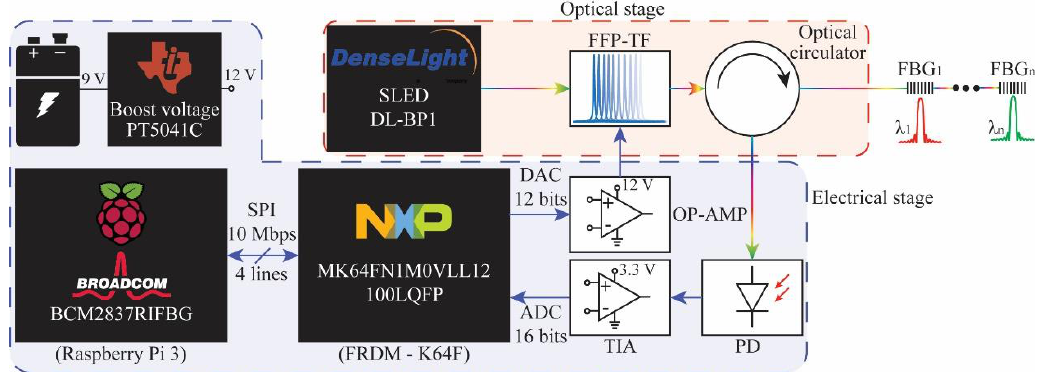
Figure 1. Schematic of the proposed interrogator, where the electrical and optical stages are in dashed and dashed-dotted lines, respectively. FBG: Fiber Bragg grating, FFP-TF: Fiber Fabry-Perot tunable filter, SLED: Superluminescent light-emitting diode, DAC: Digital-to-analog converter, ADC: Analog-to-digital converter, OP-AMP: Operational amplifier, PD: Photodetector, TIA: Transimpedance amplifier .